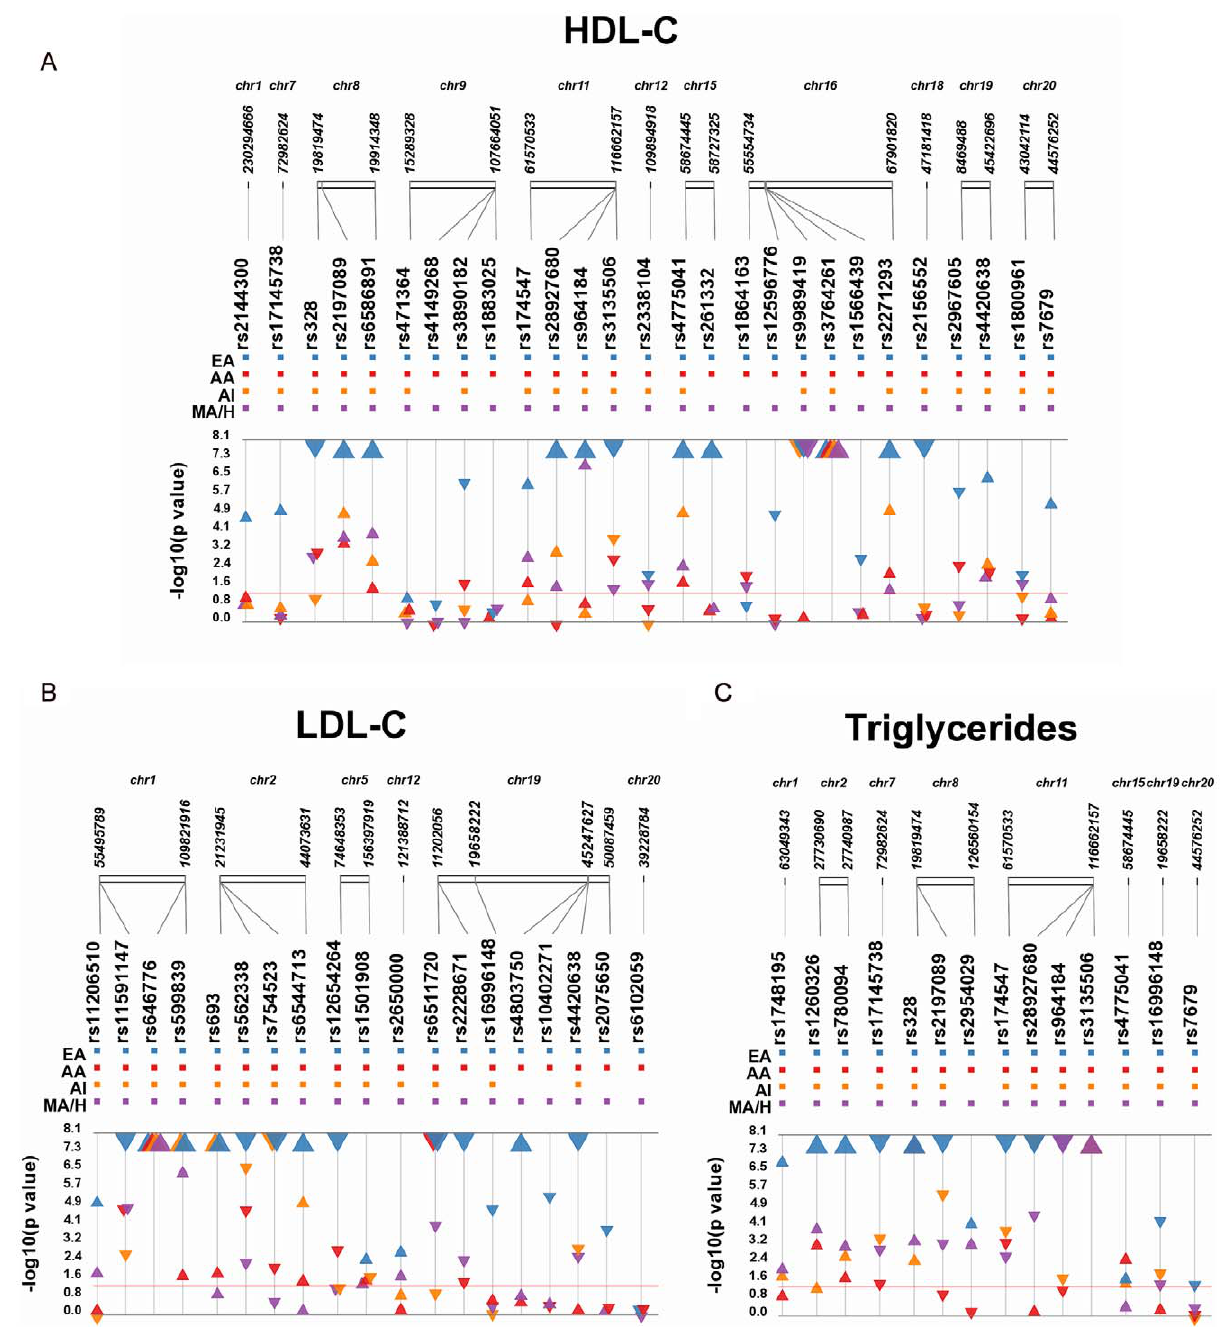
Figure 1. Meta-analysis results for GWAS–identified SNPs by population. Each SNP was tested for an association with the indicated trait assuming an additive genetic model adjusted for age and sex. Meta-analysis was performed, and p-values ( 2 log 10 transformed) of the meta-analysis are plotted along the y-axis using Synthesis-View [73,74]. SNP location is given on the x-axis. Each triangle represents a meta-analysis p-value for each population. Populations are color-coded as follows: European Americans (blue; EA), African Americans (red; AA), Mexican Americans/Hispanics (orange; MA/H), and American Indians (purple; AI). Large triangles represent p-values at or smaller than genome-wide significance (p , 10 2 8 ). The direction of the arrows corresponds to the direction of the beta coefficient. The significance threshold is indicated by the red bar at